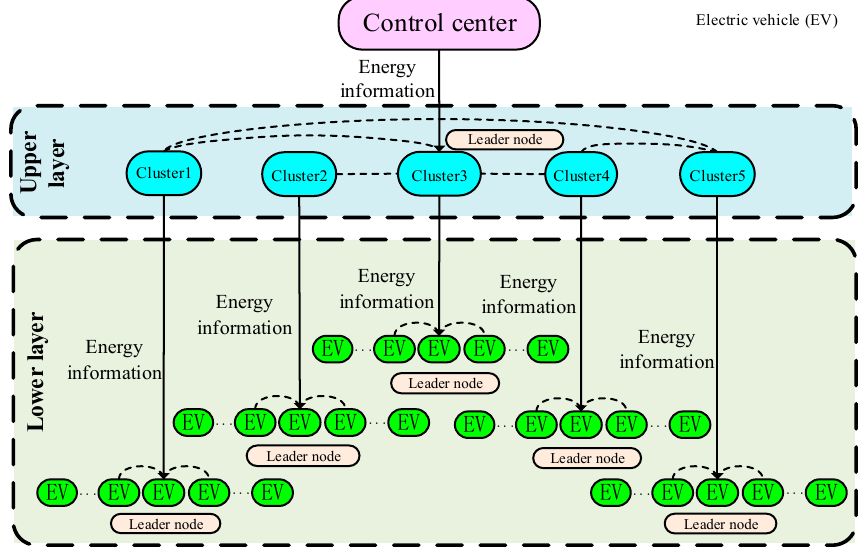
Figure 1. Communication topology of the mobile energy storage system (MESS).